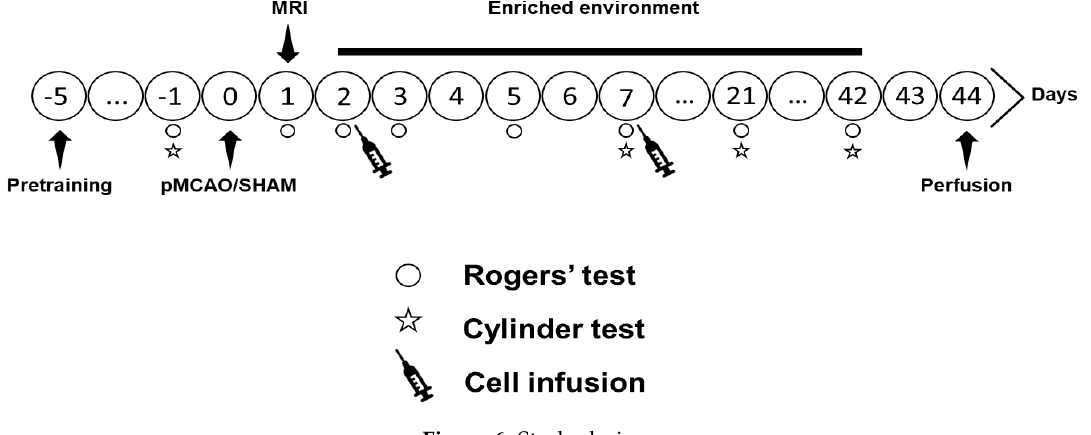
Figure 6. Study design.